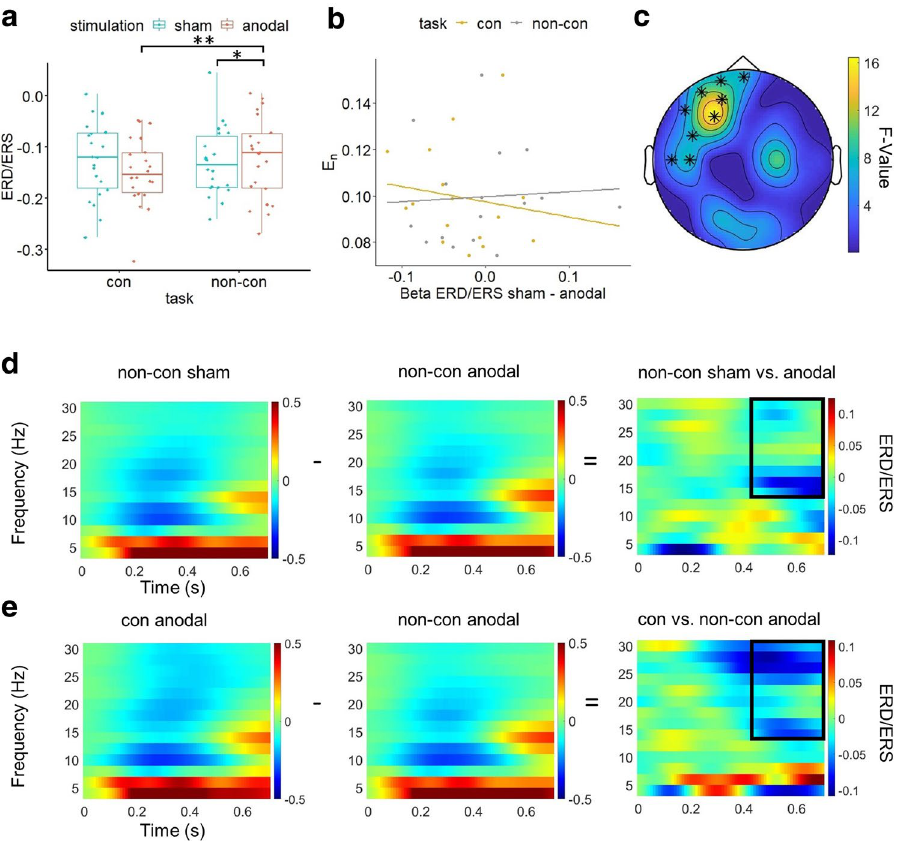
Figure 6. Stimulation*atDCS + target task interaction effect on Flanker task related beta ERD/ERS. (a) Boxplots of individual beta ERD/ERS averaged over channels and time in significant stimulation*atDCS + target task interaction cluster (AF7, Fp1, AF3, C5, Fpz, F3, F7, FC5, T7; 430–700 ms) for sham and anodal stimulation, separated for concurrent (con) and non-concurrent (non-con) task condition (* p < 0.05, ** p < 0.01). (b) Scatter plot with regression lines of stimulation effect (sham-anodal) on Beta ERD/ERS and individual normal E-field component (E n ) for concurrent (con) and non-concurrent (non-con) task condition. (c) Topography of significant stimulation*atDCS + target task interaction effect of Flanker related beta ERD/ERS marked by asterisks. (d) Flanker task related time–frequency representation (TFR), averaged across electrodes forming significant stimulation*atDCS + target task interaction cluster. From left to right: Flanker task TFR following non-concurrent sham stimulation, TFR following non-concurrent anodal stimulation, difference in TFR for non-concurrent condition between sham and anodal stimulation. The black box indicates the significant difference in beta oscillatory power between both conditions. (e) Flanker TFR, averaged across electrodes forming significant stimulation*atDCS + target task interaction cluster. From left to right: Flanker task TFR following concurrent anodal stimulation, TFR following non-concurrent anodal stimulation, difference in TFR for anodal stimulation condition between concurrent and non-concurrent task condition. The black box indicates significant difference in beta oscillatory power between both conditions. Figures were created using MATLAB (Version 2018a, https:// www. mathw orks. com/), FieldTrip (Version 20190712, https:// www. field tript oolbox. org/) and the computing environment R (Version 3.6.1, R Core Team (2019), https:// www.R- proje ct.